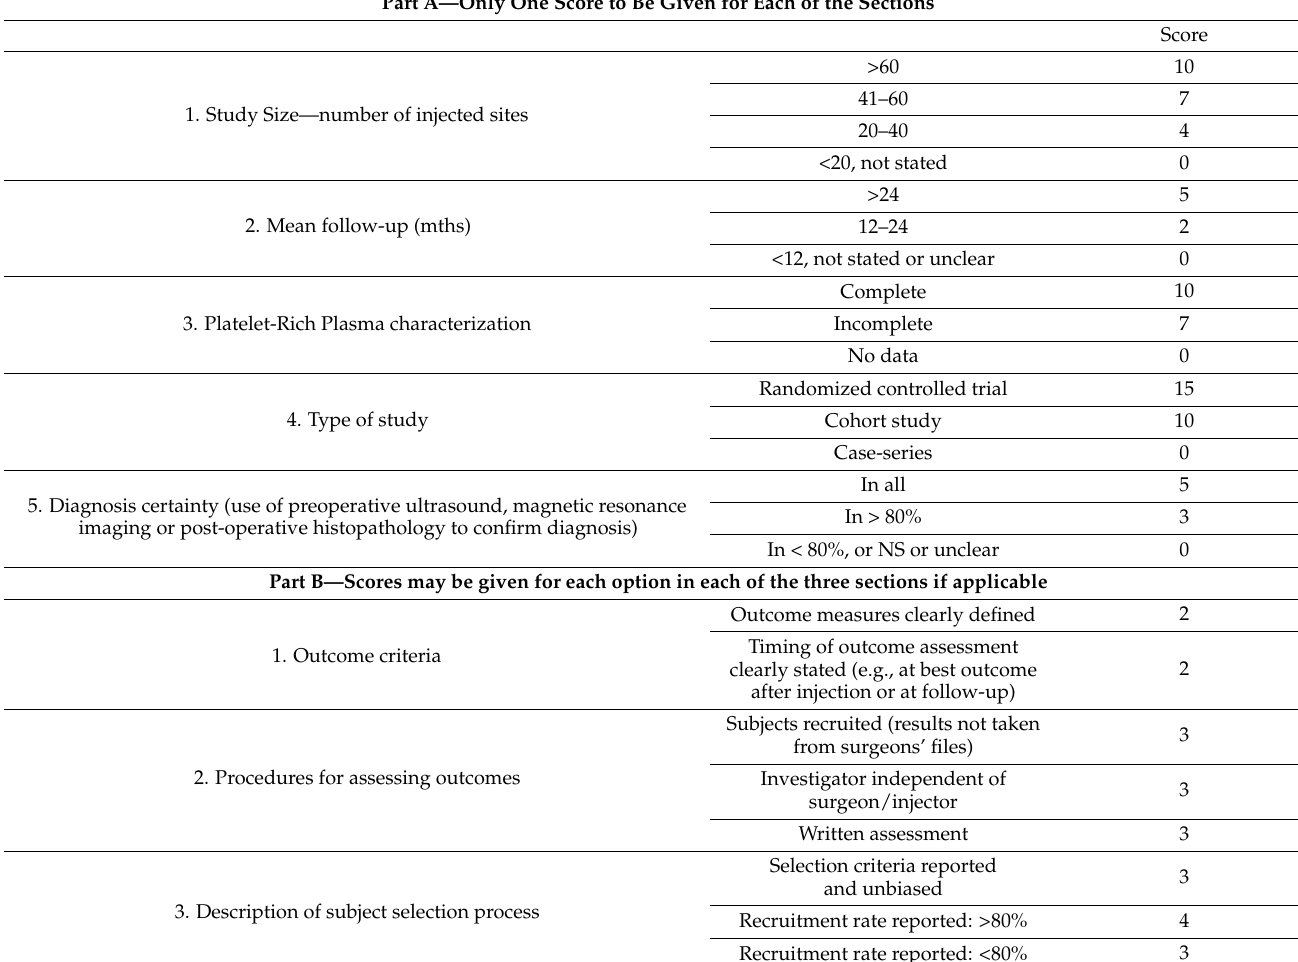
Table 1. Modified Coleman methodology